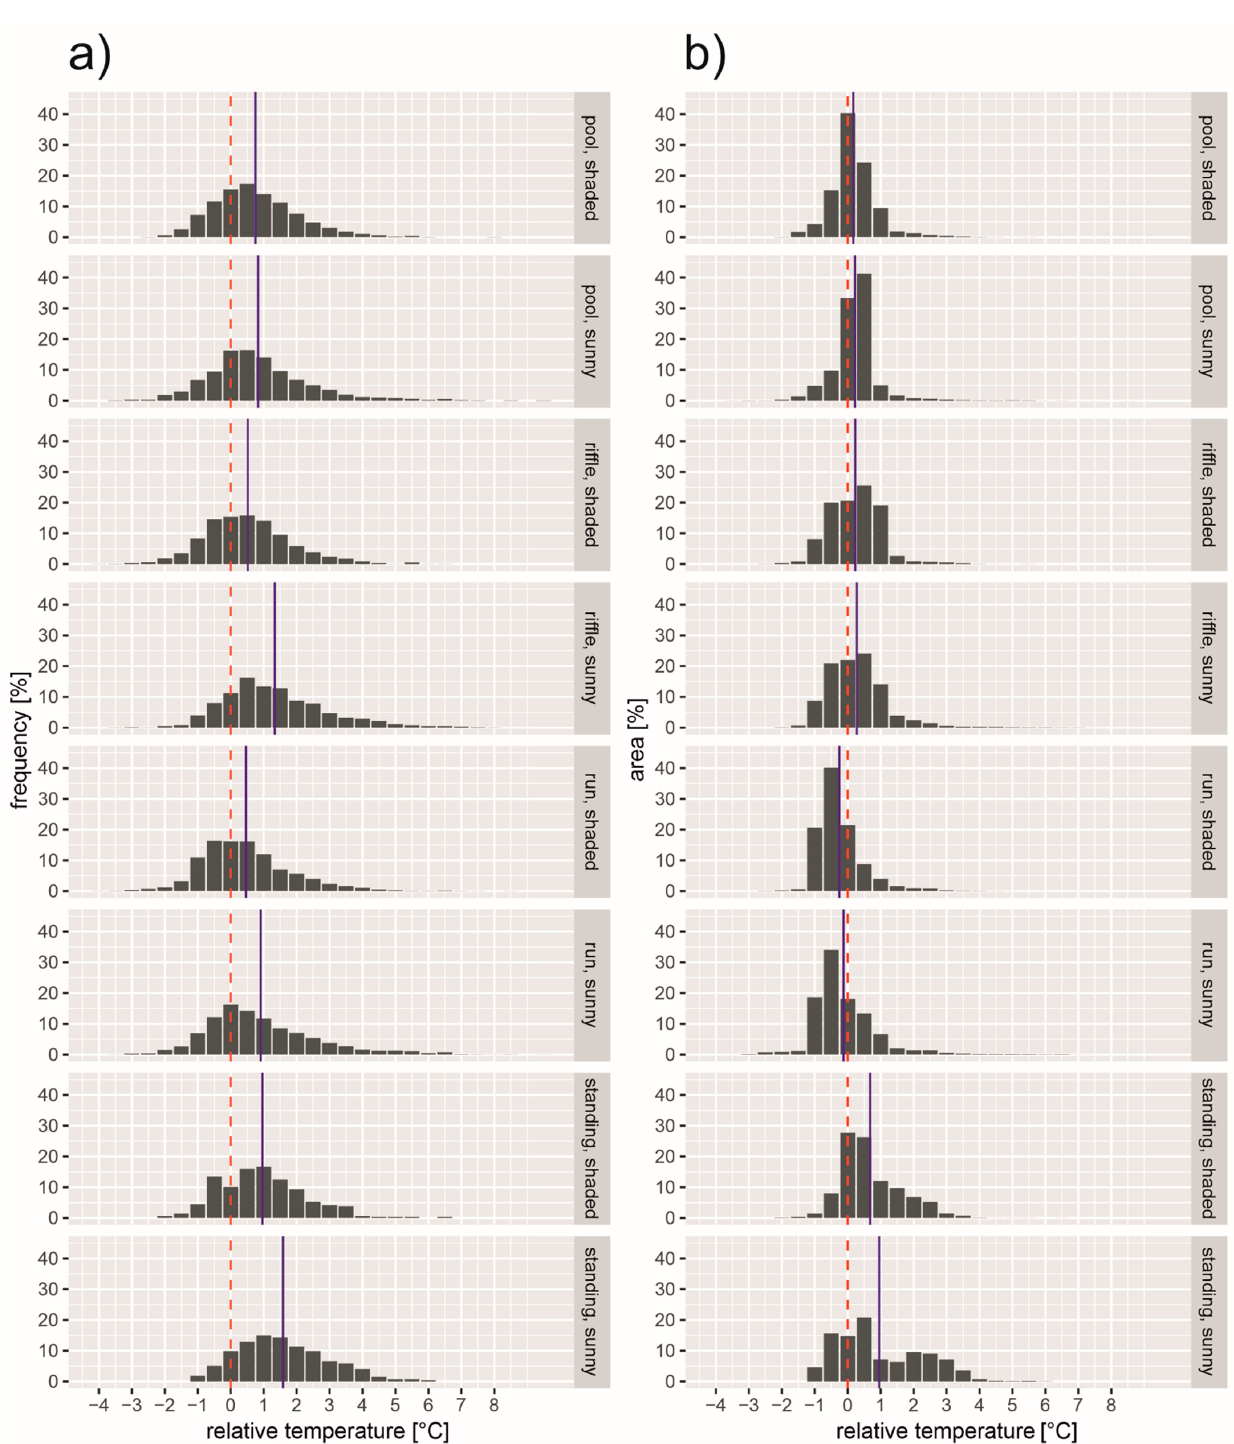
Figure 4. Histograms of ( a ) frequency and ( b ) areal distribution of relative temperatures for each MH class, including shaded and sun-exposed. The dashed lines indicate the zero reference for each calculated relative temperature (in relation to the mean survey reach temperature), and the continuous blue line indicates the calculated average relative temperature.